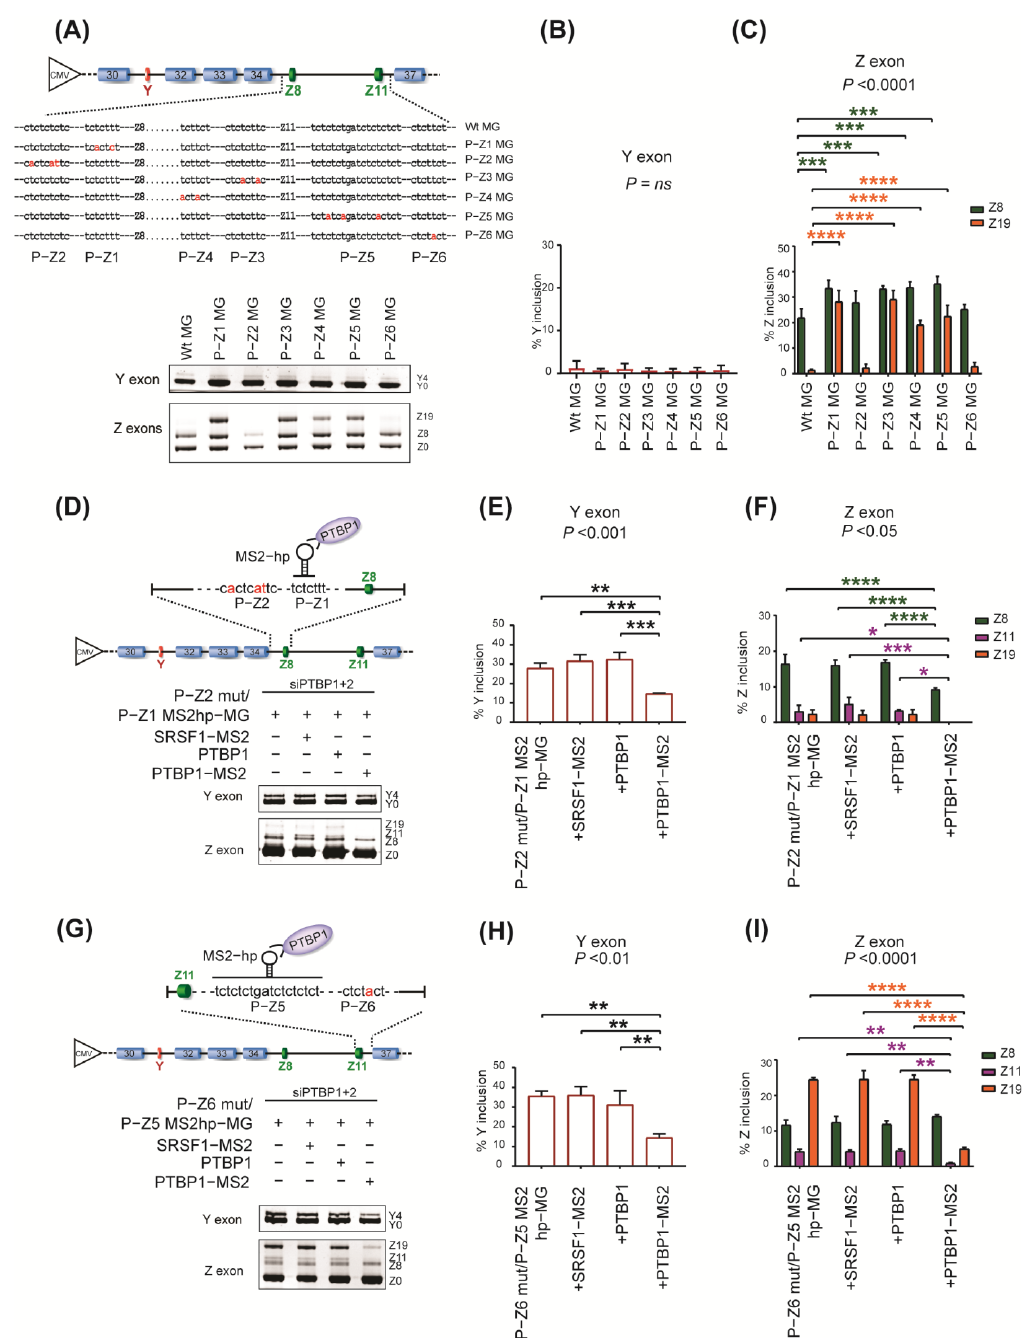
Figure 4. The roles of PTBP1 binding sites around Z exons for the splicing repression of Y and Z exons. ( A ) Schematic showing wild − type minigene (Wt MG) and mutant minigenes (P − Z1 to P − Z6 MG) carrying mutations at the predicted PTBP1 − binding sites around Z exons. Mutations are indicated in red. RT − PCR ( bottom panel ) showing splicing of Y and Z exons for wild − type and mutant